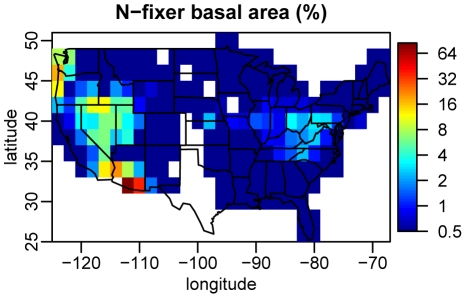
Geographical pattern of N fixer abundance.Grid cells are 2° latitude by 2° longitude. Values are the percentage of total basal area in each grid cell comprised by N fixers. Note the logarithmic color scale. All grid cells with a value <0.5% were assigned the value 0.5% in the map. White spaces reflect grid cells with fewer than 20 FIA plots.